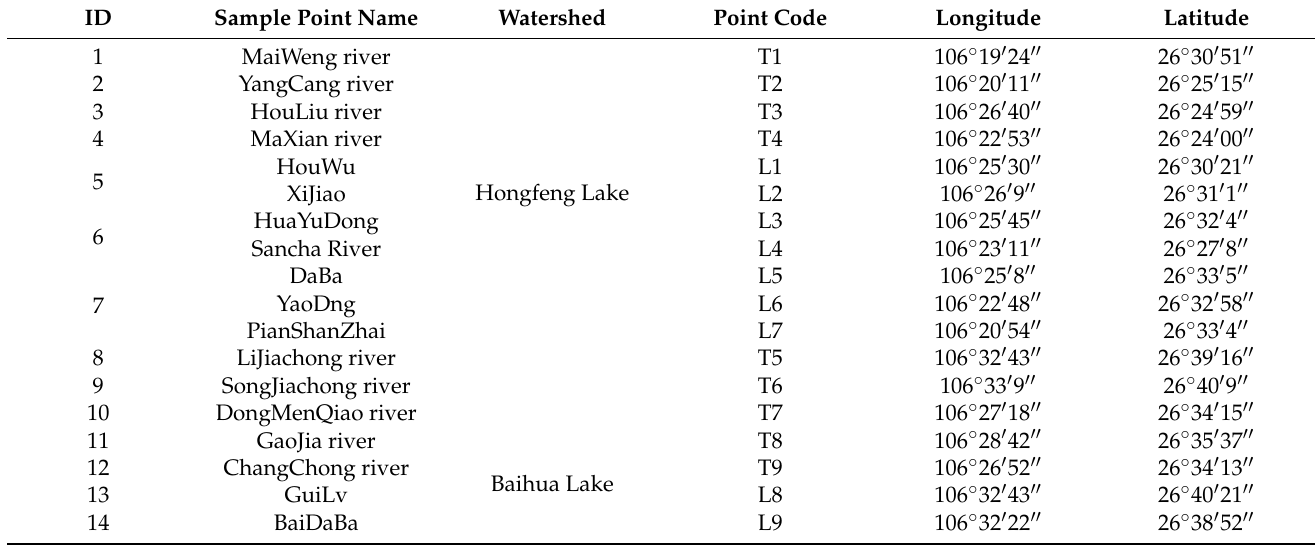
Figure 1. Locations and monitoring points in the study area: ( a ) Tributary monitoring points; ( b ) Reservoir monitoring points. Table 1. Monitoring units and their corresponding monitoring